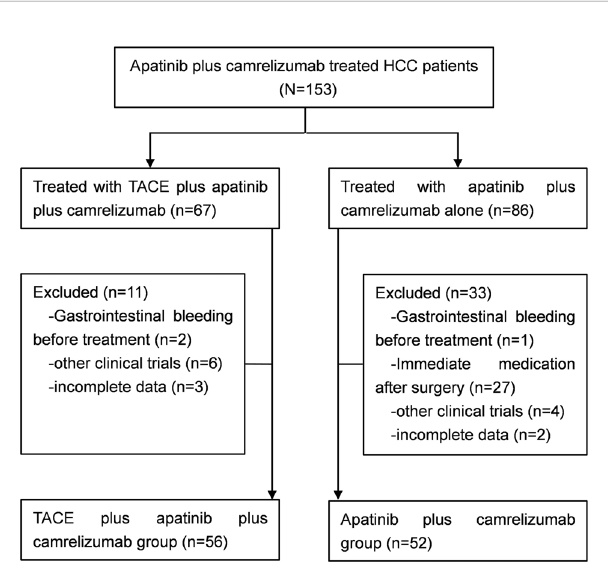
FIGURE 1 | Study fl ow. HCC, hepatocellular carcinoma; TACE, transcatheter arterial